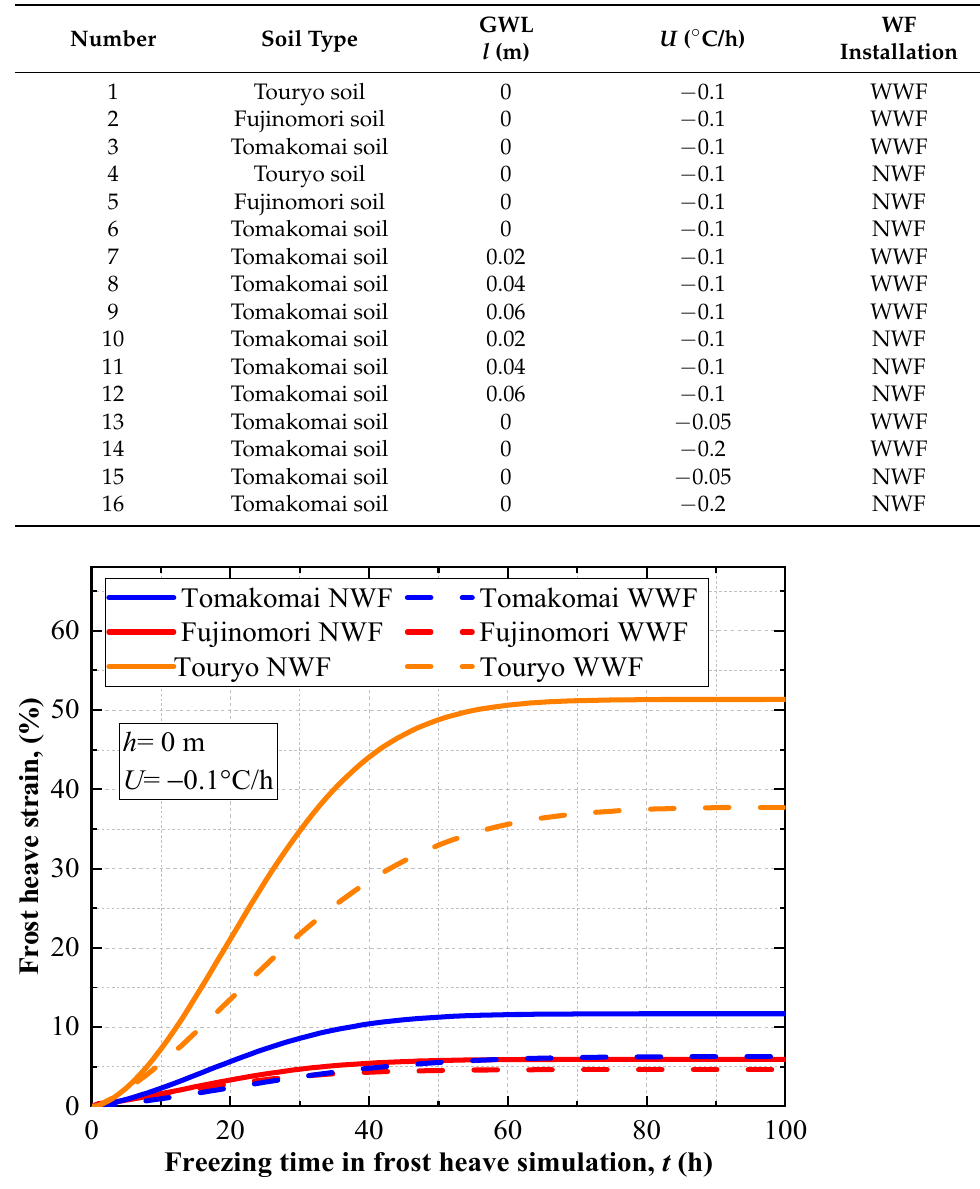
Figure 10. Effect of soil types on frost heave and WF inhibiting effect.